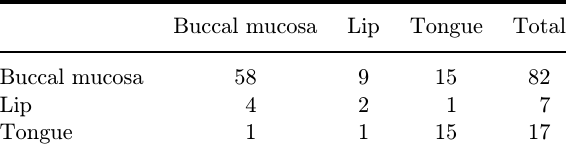
Table 4. PC-LDA for identifying anatomical di®erences at buccal mucosa, lip and tongue subsites in premalignant